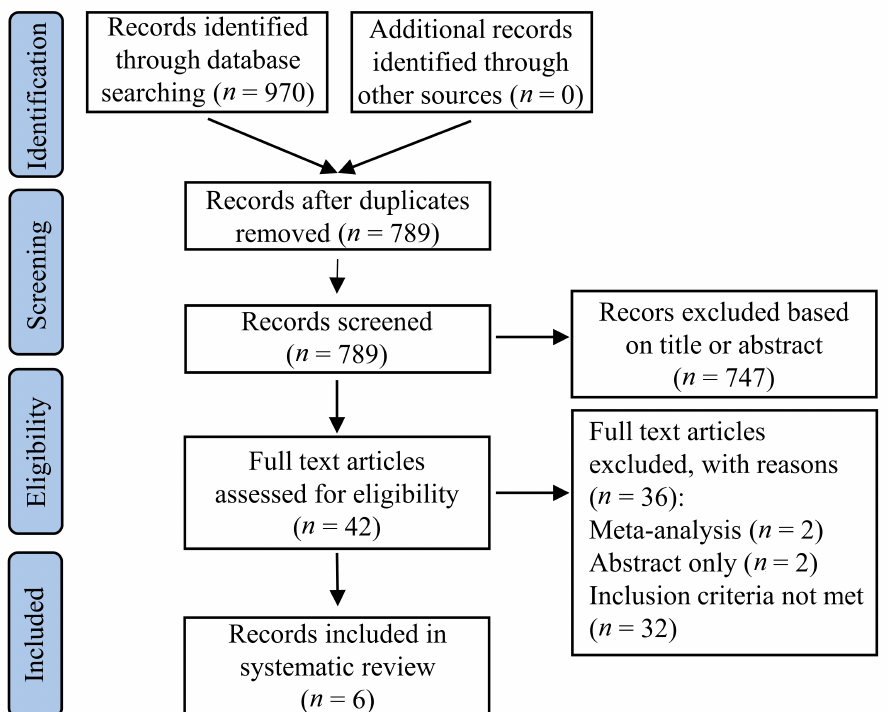
Figure 1. Flow diagram of the studies selection for inclusion in the systematic review.